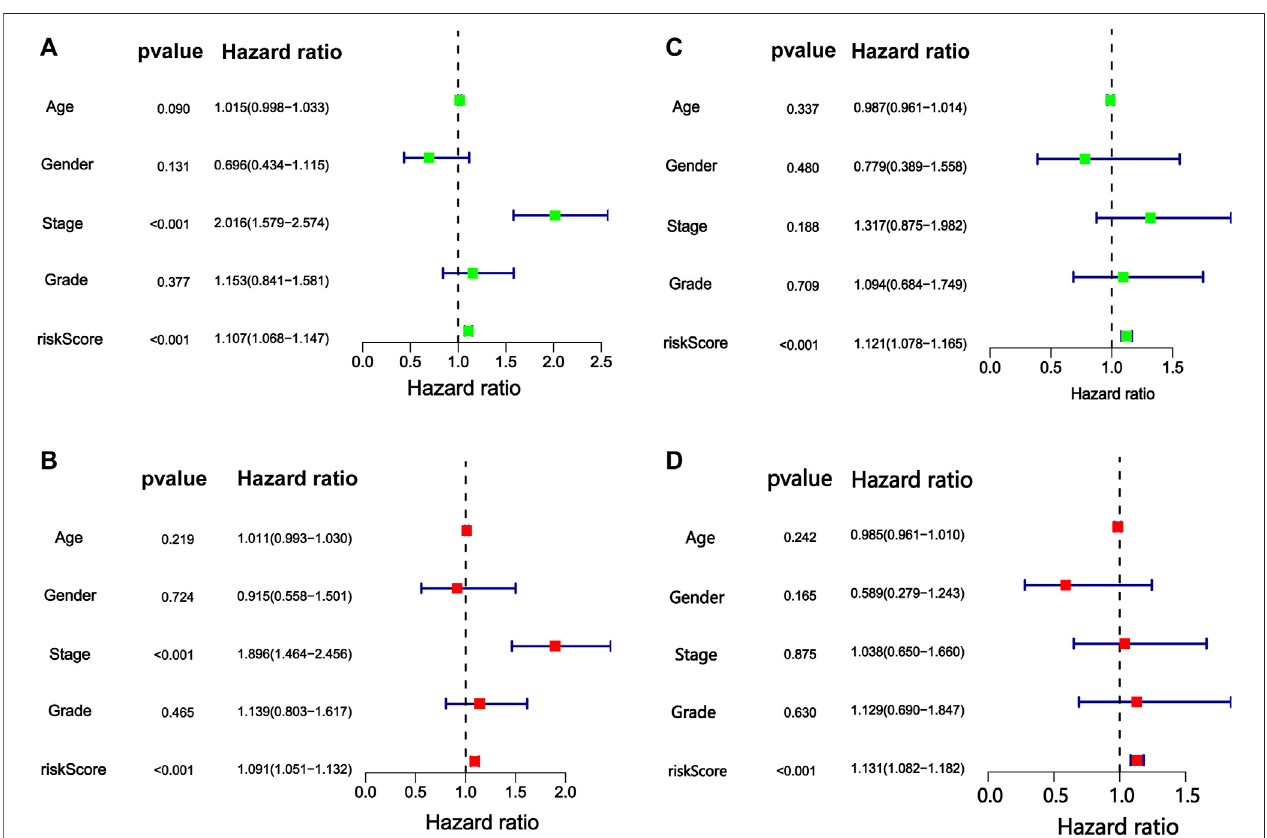
FIGURE 7 | Cox proportional hazards regression analysis of risk score of m6A-9LPS combined with clinical factors. The forest map of (A) univariate and (B) multivariate Cox regression analysis in the training cohort. The forest map of (C) univariate and (D) multivariate Cox regression analysis in the validation cohort.